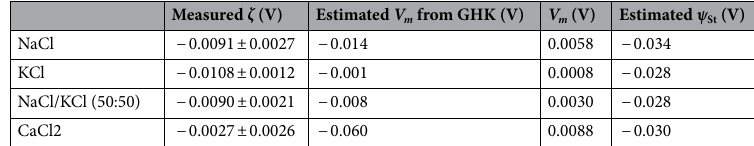
Table 2. Estimated electrical properties of RBCs in different ionic media. The measured value of ζ in different ionic media, together with the calculated value of V m for each medium determined using the GHK equation. We used the calculated value of V m to determine a Ξ = 0.27, and determine ζ’ using Eq. (5). This was used in Eq. (4) to estimate ψ St due solely to the surface charge, which showed a high degree of similarity across the four